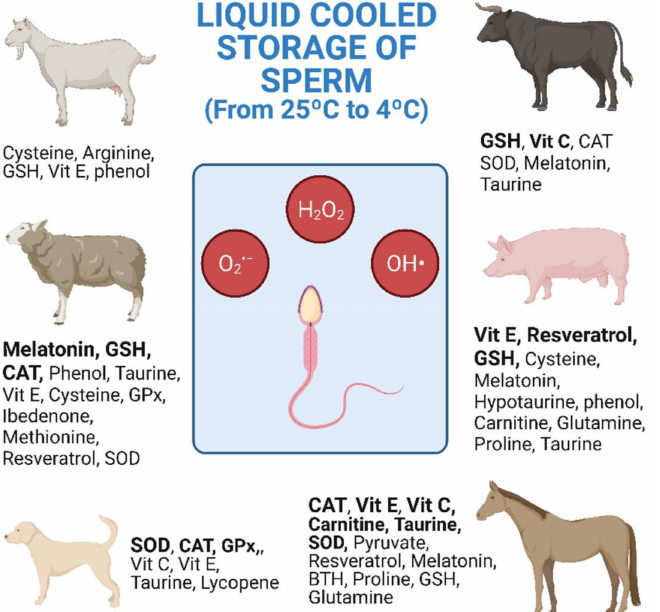
Figure 1. Antioxidants used in cooled semen storage by species. Research studies listed in Tables 1–3 collected together and distributed by animal species. Bold: 2 or more different research studies carried out (both alone and in combination) (Created with